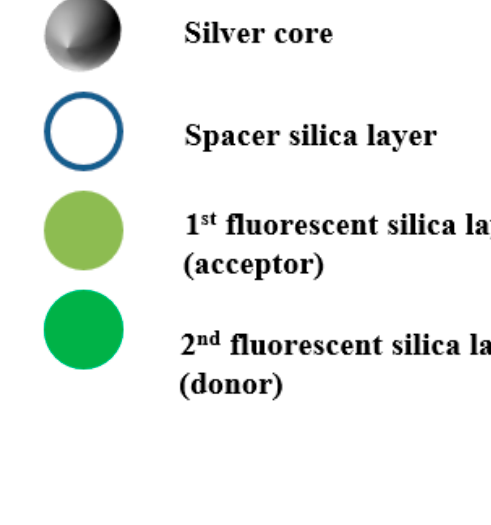
Figure 10. Schematic showing the Au nanorod@Ag core–shell nano-system coated with SiO 2 mono- layer. Adapted from Ref. [73]. For a planar structure, using a layer-by-layer assembly technique, a polymer electro- lyte is used as a spacer layer, which can e ff ectively adjust to the distance between semi- conductor quantum dots and the layers of the noble metal, which not only makes the ad- justment of the layer more precise but also eliminates the in fl uence of energy transfer in- side the quantum dot layer, which is caused by an uneven size. Lunz et al. [74] fi rst